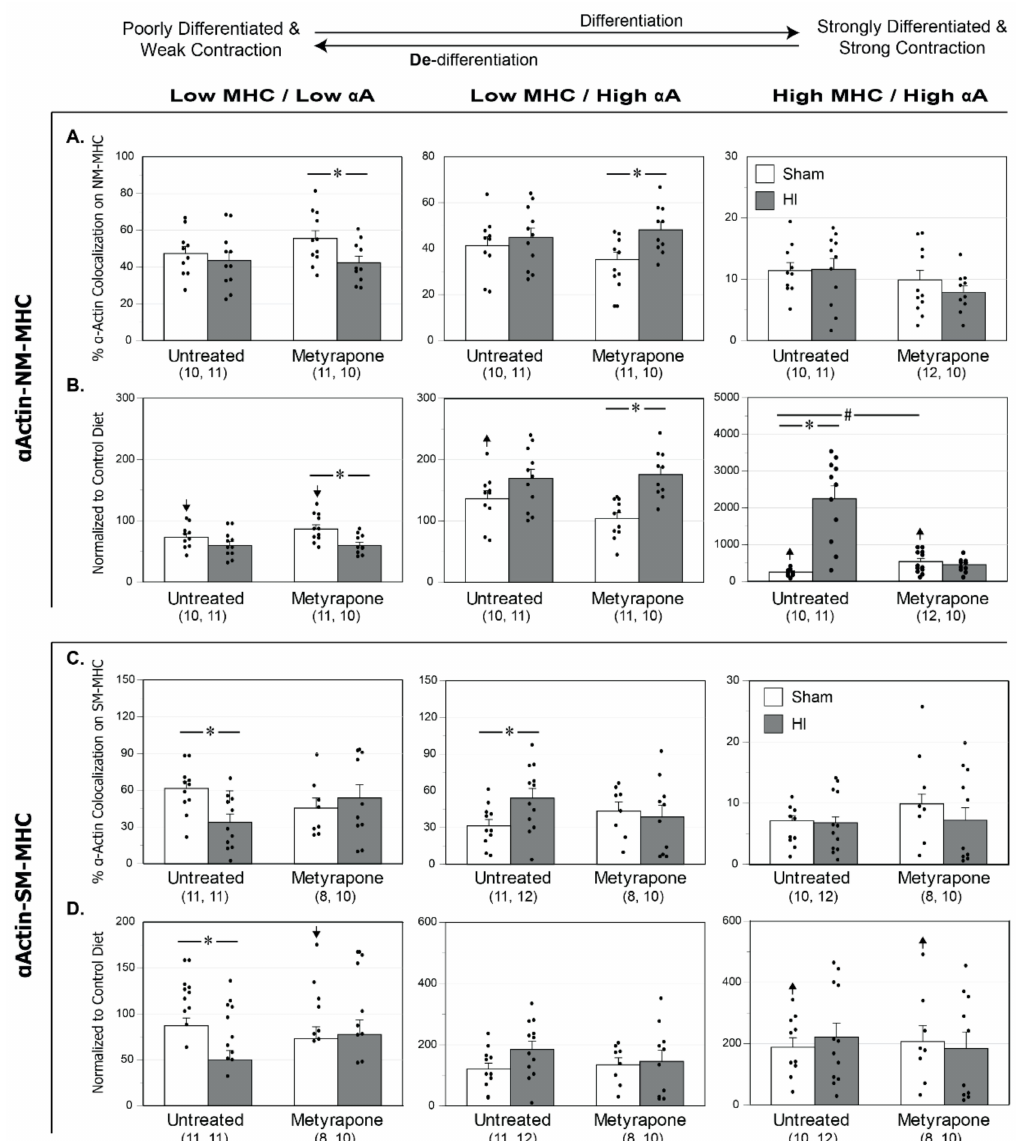
Figure 4. Effects of HI, gestational MET and MUN on Confocal Colocalization of Smooth Muscle Contractile Proteins. Confocal microcopy allowed for the assessment of contractile protein organization of α Actin with two different myosin heavy chain isoforms: (a) NM-MHC, and (b) SM-MHC. ( A , B ) depict NM-MHC data, while ( C , D ) depict SM-MHC data. Confocal coefficients of colocalization were sorted into three distribution groups: Low MHC/Low α Actin, Low MHC/High α Actin, High MHC/High α Actin. For ( A , C ), within each experimental group, all subgroups totaled to 100%. Note that the vertical scale for each of the three distribution groups differ (100% vs. 80% vs. 30%). In relation to smooth muscle phenotype, a leftward shift in pixel counts (e.g., decreased High-High and increased Low-Low values) suggests contractile de-differentiation, and vice versa. Columns and error bars overlaid with dot plots indicate SEM for raw MUN data. For ( B , D ) columns and error bars overlaid with dot plots indicate MUN colocalization values normalized to CD values for each category. ANOVA with a post-hoc Fisher’s LSD determined the statistical significance as shown by: * for differences between Sham and HI groups and # for differences between MET-Sham and Untreated-Sham groups. Up and down arrows denote significant differences ( p < 0.05) between normalized values of MUN and 100% for both Untreated- and Metyrapone-Sham groups; an up arrow indicates a significant enhancement by MUN whereas a down arrow indicates a significant attenuation by MUN. To improve visual clarity, significant differences between Untreated-HI and MET-HI are not shown. Parentheses at the bottom of each graph display n values for each